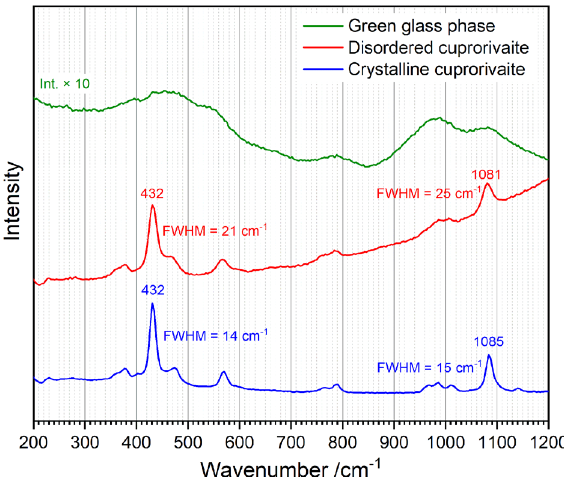
Figure 4. Comparison of the Raman spectra of the green glass phase (intensity × 10; acquired on the pigment ball unearthed in Augusta Raurica) and disordered as well as crystalline cuprorivaite (both from the same Raman map of the pictorial layer of the mural fragment excavated in the remains of Augusta